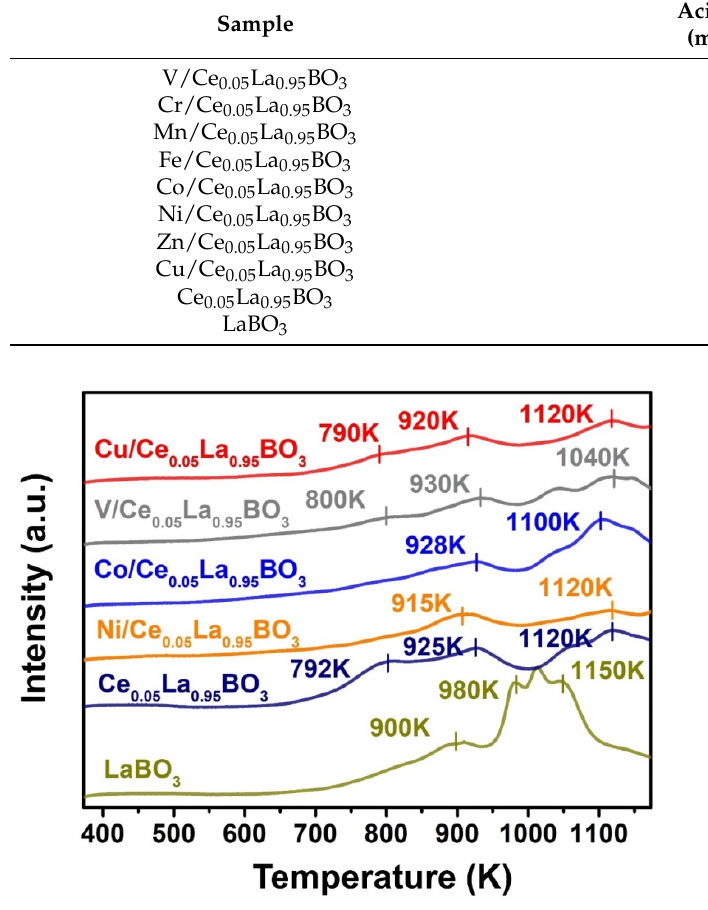
Figure 6. NH 3 -TPD profiles of Cu/Ce 0.05 La 0.95 BO 3 , Ni/Ce 0.05 La 0.95 BO 3 , Co/Ce 0.05 La 0.95 BO 3 , V/Ce 0.05 La 0.95 BO 3 , Ce 0.05 La 0.95 BO 3 , and LaBO 3 .